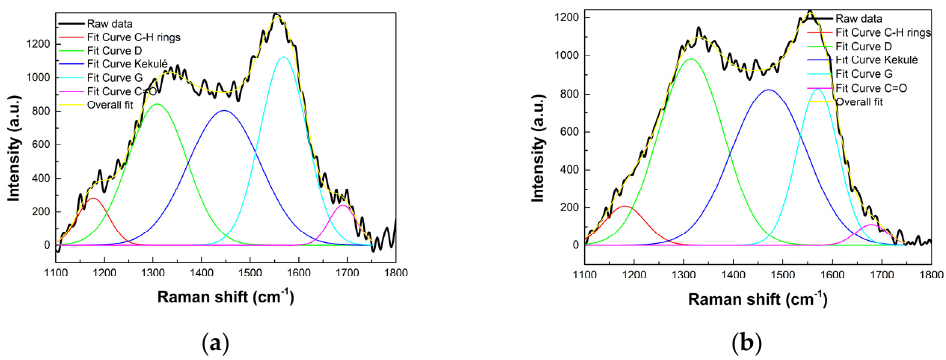
Figure 2. Decomposition of Raman spectra into five Gaussian components of ( a ) WP-CDs-1 and ( b ) WP-CDs-5, and the corresponding labelled bands. Table 4. Characterization of decomposed Raman modes for WP-CDs-1 and 5.